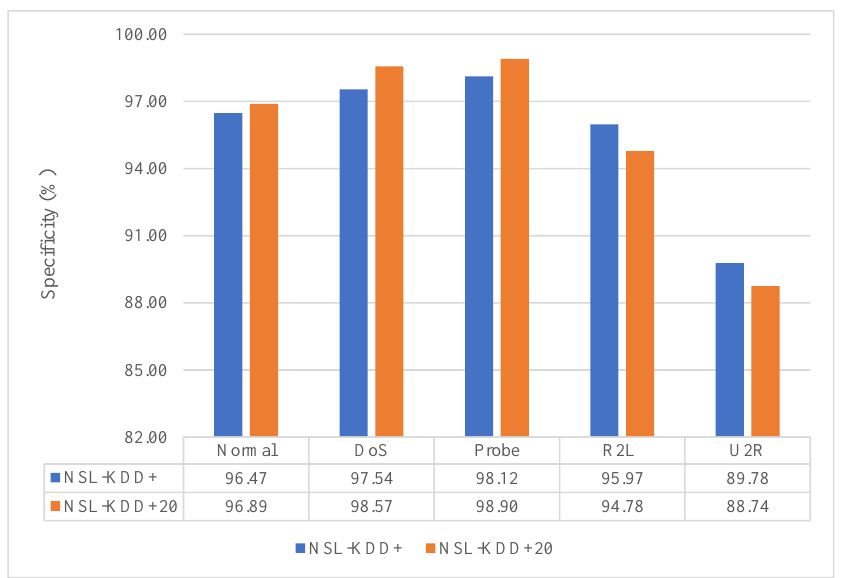
Figure 4. Recall rate of different classes on NSL-KDD+ and NSL-KDD+20 datasets.